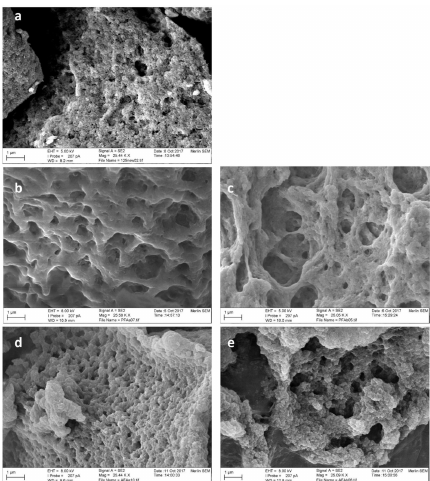
Figure 8. SEM photographs of FAE125 CLEAs before and after use in transesterification reactions, at 25,000 × . ( a ) FAE125 CLEAs before use; ( b ) FAE125 CLEAs after one round of PFA synthesis; ( c ) FAE125 CLEAs after two rounds of PFA synthesis; ( d ) FAE125 CLEAs after one round of